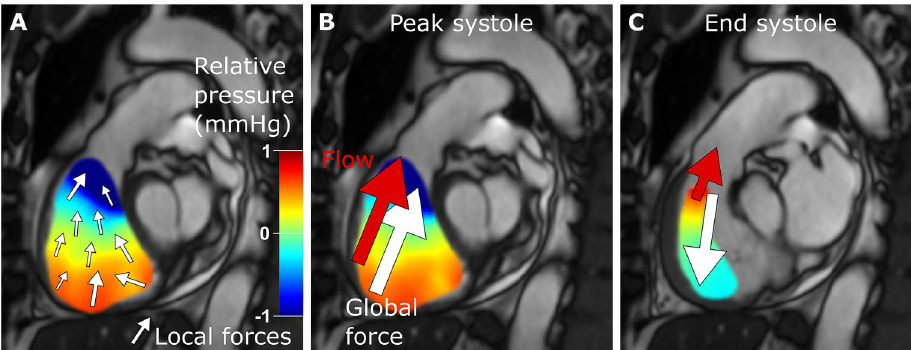
Figure 1. Right ventricular outflow tract in one patient with precapillary pulmonary hypertension: relative pressure gradients, hemodynamic forces and flow. ( A ) The colored field illustrates the relative pressure gradients. Local hemodynamic forces are illustrated with white arrows, with direction and magnitude indicated for each point. ( B ) The global force (white arrow) is a sum of all local forces and drives the blood flow (red arrow) towards the pulmonary artery during systole. ( C ) By the end of systole, the global force is directed in the opposite direction of the flow, thereby decelerating the blood. The global force is analyzed in three directions for each ventricle (Fig. 2).